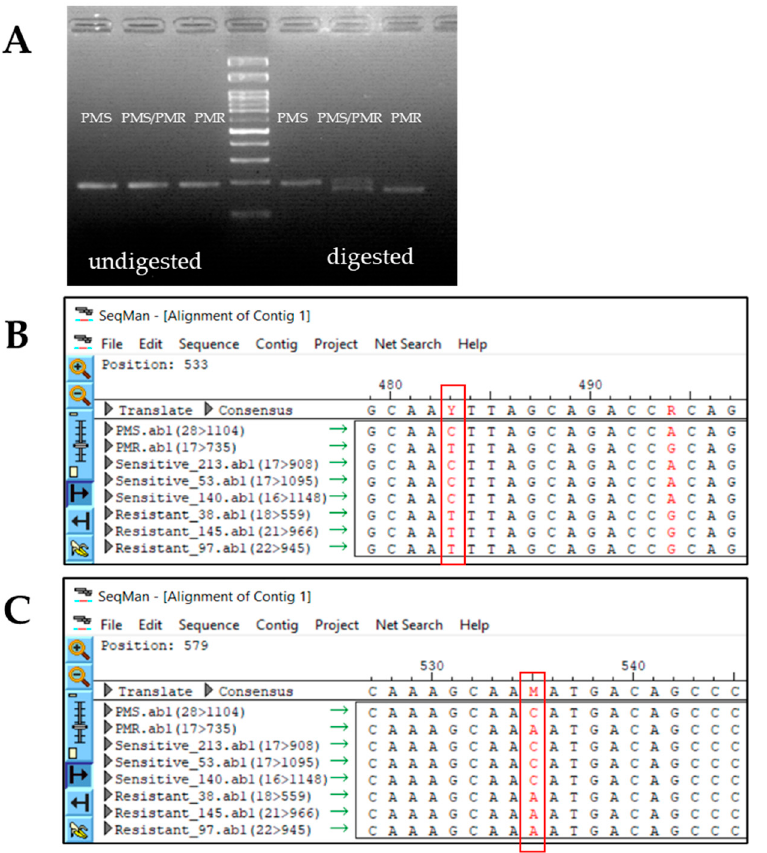
Figure 4. Profiles of designed SNPs, differentiating PMS and PMR lines. ( A ) Amplification profile of pumpkin lines showing polymorphism of the CmoAP2/ERF dCAPS marker. The PMS, PMS/PMR, and PMR lines amplified using the CmoAP2/ERF dCAPS marker ( right ) and band patterns after restriction digestion with Pst1 ( left ). ( B ) Coding sequence alignment of PMS/PMR lines, along with three PM sensitive and three PM resistant lines for SNP verification. Sequence alignments of selected lines and the red box indicate SNP variation at SNP C3. 7419839. ( C ) Coding sequence alignment of PMS/PMR lines, along with three PM sensitive and three PM resistant lines, for SNP verification. Sequence alignments of selected lines and the red box indicate SNP variation at SNP C3. 7419891. Table 2. Co-segregation analysis of the CmoAP2/ERF gene in the PMS x PMR-F2 population.